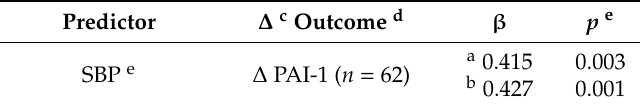
Table 1. First step a and final b multivariate regression analyses between inflammatory biomarkers and intervention elements (predictors) in the studied pre- and hypertensive